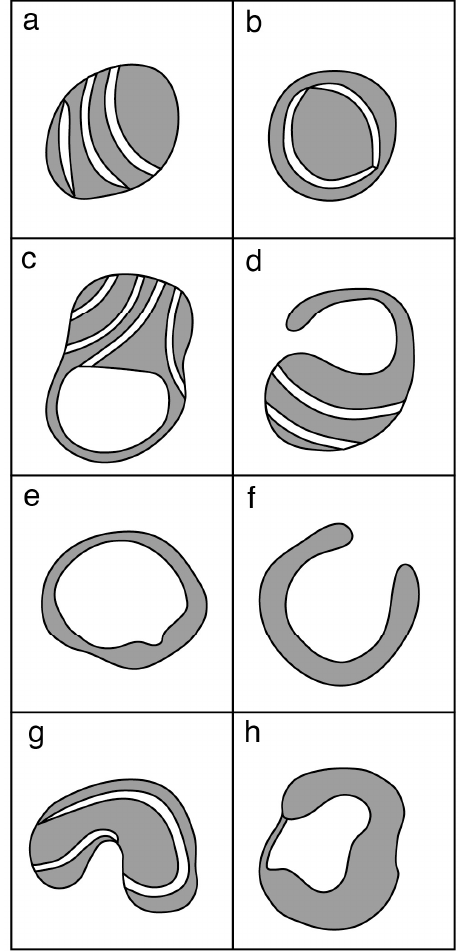
Figure 2. Diagram of the profiles of mitochondria observed in TEM images of oocytes from the human, cow, sheep, pig and mouse: ( a ) typical spherical with transverse cristae; ( b ) spherical with peripheral cristae; ( c ) vacuolated; ( d ) hooded or cap-shaped; ( e ) ring-shaped; ( f ) cup- or horseshoe-shaped; ( g ) elongated, irregular; and ( h ) shell-like. Profile ( a ) has been observed in oocytes from all these species; ( b ) in all except sheep; ( c ) in cow, sheep and mouse oocytes; ( d ) in human, cow and sheep oocytes; ( e ) in cow and mouse; ( f ) in human and sheep; ( g ) in pig; and ( h ) in sheep, pig and mouse. See text for references.